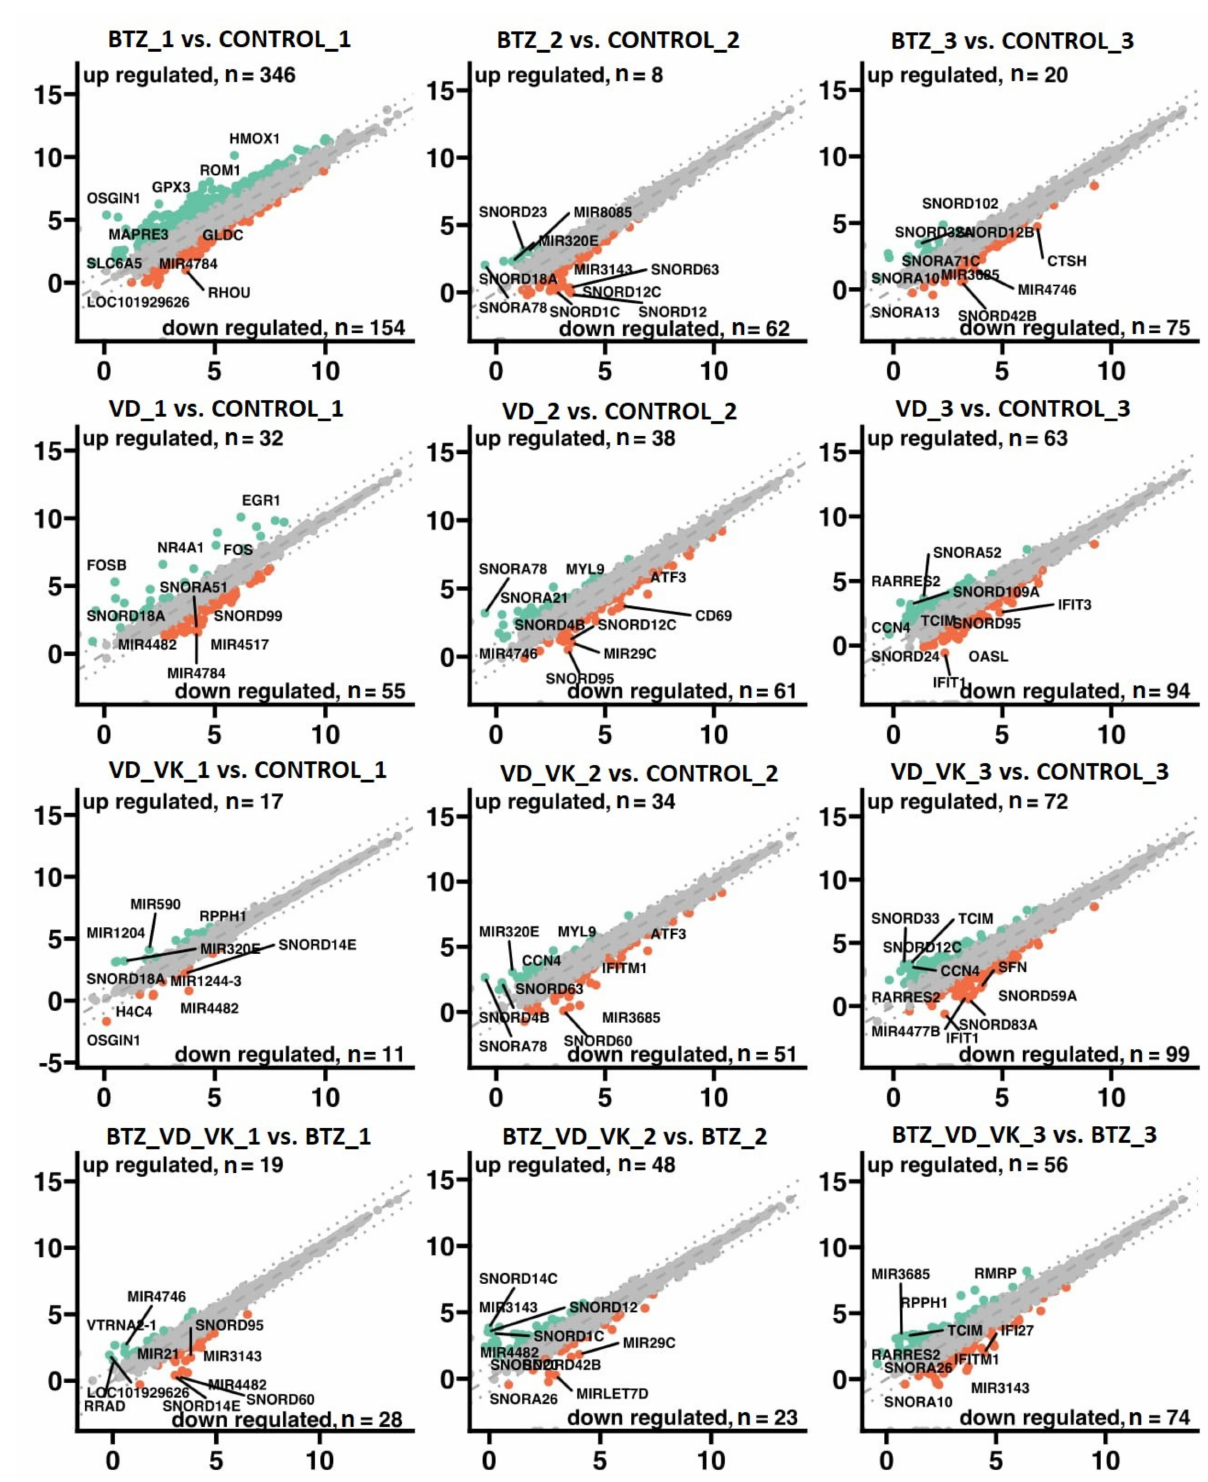
Figure 6. Gene expression profiles obtained in bioinformatics analysis of U266 myeloma cells after treatment with BTZ, VD and VK. Gray dots show genes with a fold <2 or p > 0.05 cutoff from the analysis. The red dots show the genes with decreased expression compared to the control, while the green dots show the genes with increased expression compared to the control. The graphs show the symbols of the most altered